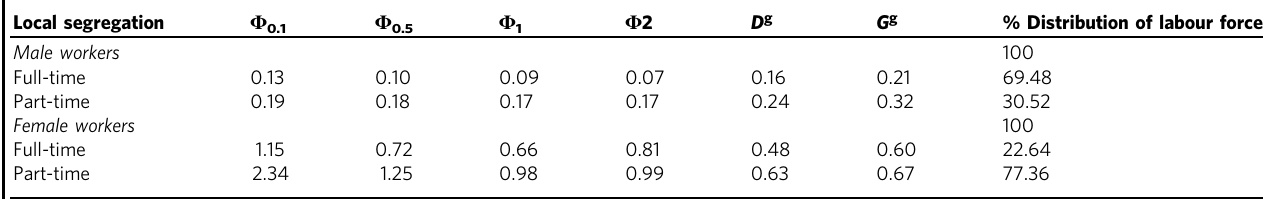
Table 9 Occupational gender segregation by hours of work.